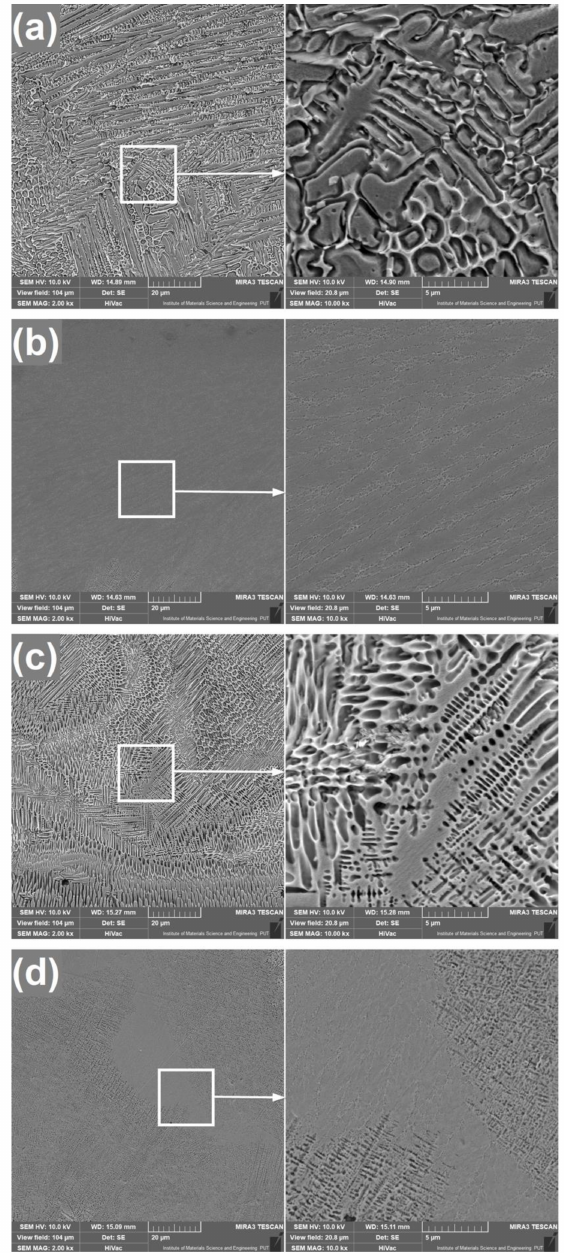
Figure 4. Microstructures of laser borided layers produced on Monel 400 with di ff erent parameters: ( a ) v l = 5 m / min and t b = 100 µ m, ( b ) v l = 5 m / min and t b = 200 µ m, ( c ) v l = 50 m / min and t b = 100 µ m, ( d ) v l = 50 m / min and t b = 200 µ